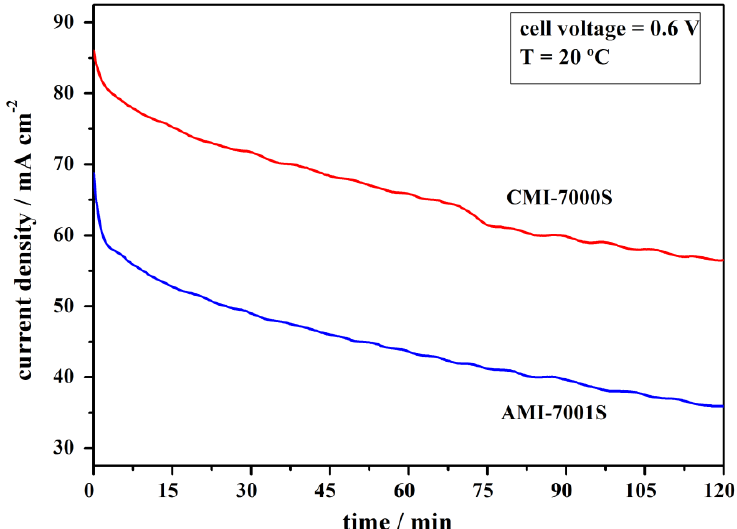
Figure 4. Current density versus time at an imposed cell voltage of 0.6 V for DBPFCs employing AMI-7001S and CMI-7000S membrane